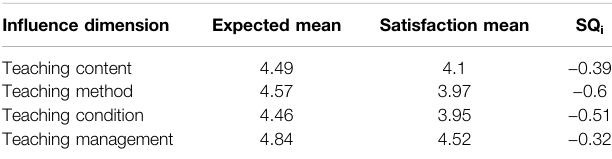
TABLE 9 | Teaching quality gap